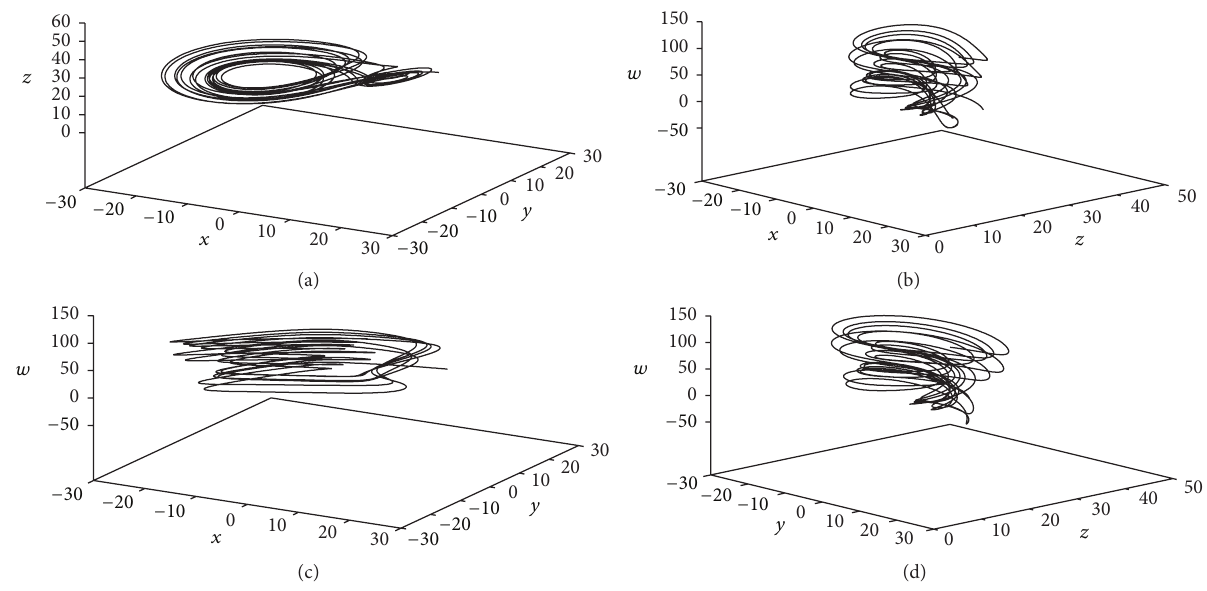
Figure 4: Phase portraits using 15-term MHPM on Δ𝑡 = 0.001 of Case 1 hyperchaotic L¨u